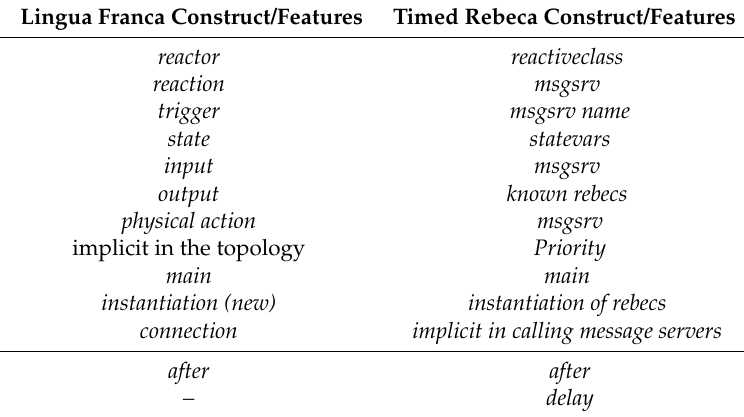
Table 1. The mapping between Lingua Franca and Timed